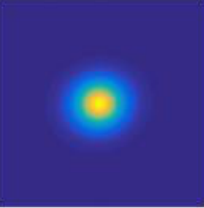
Figure 9. A strong response map fused by four weak response maps with adaptive